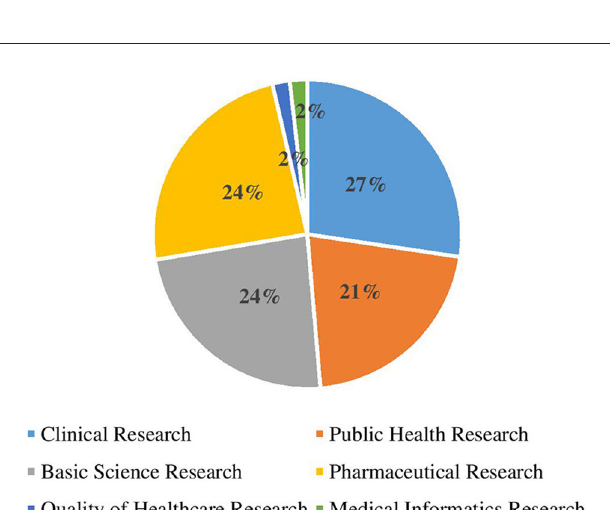
FIGURE2 Broad areas of ongoing health research projects by respondents.